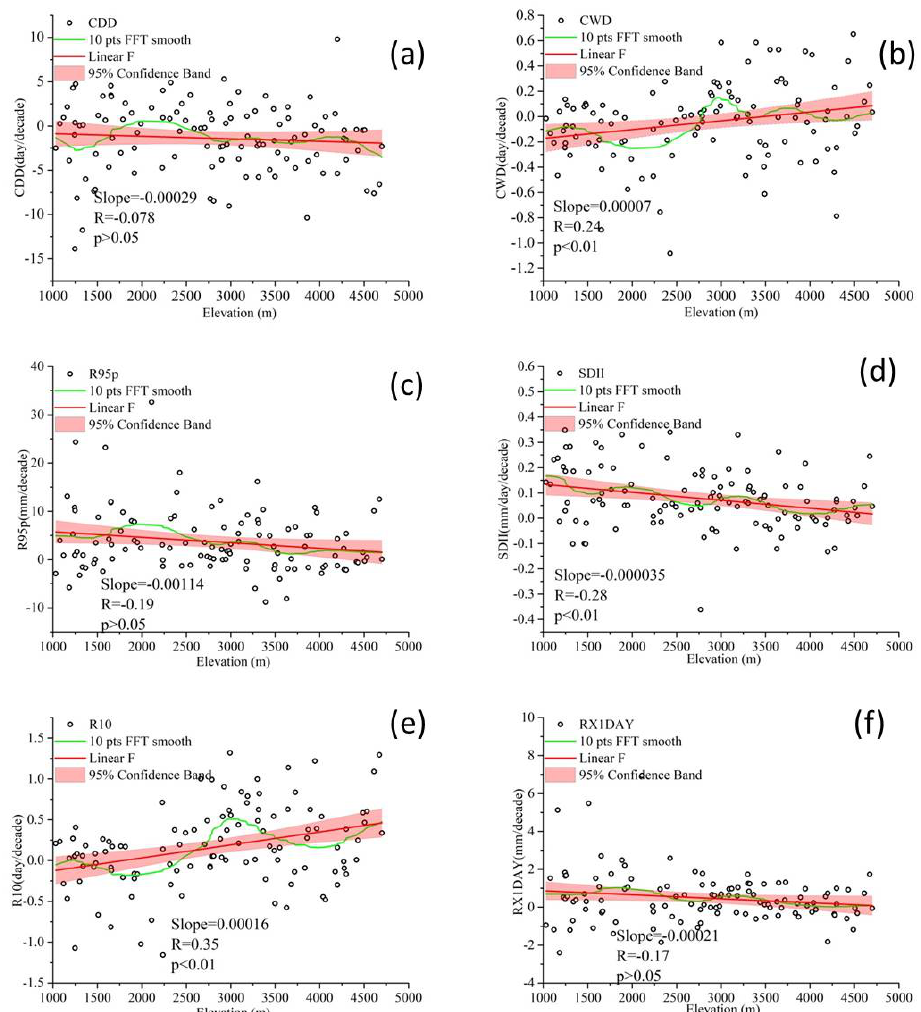
Figure 9. Scatter plots of trends (mm/decade) by elevation for extreme precipitation (( a ) CDD; ( b ) CWD; ( c ) R95p; ( d ) SDII; ( e ) R10; ( f ) RX1day) in the TP and TPS during 1971–2017. Changes in the average magnitude of each extreme precipitation index with increas- ing elevation at 500-m intervals and the number of weather stations in each gradient are shown in Figure 10. Each extreme precipitation index shows fluctuations at different ele- vations, and a simple increase or decrease with elevation was not apparent. For CDD trends, a positive correlation with elevation was observed at 1000–2000 m and a negative correlation at 2000–5000 m. However, CWD trends were more complicated; negative cor- relations with elevation were observed at 1000–2000 m, 2500–3000 m, and 3500–4000 m, and positive correlations were observed at 2000–2500 m, 3000–3500 m, and 4 000−4500 m. Positive correlations with elevation for R95p trends were observed at 1000–2000 m, 2500– 3000 m, and 4000–4500 m, and negative correlations were observed at 2000–2500 m, and 3000–4000 m. For SDII trends, negative correlations with elevation were observed at 1000– 2500 m and 3000–4000 m, and positive correlations were observed at 2500–3000 m and 4000–4500 m. For R10, negative correlations with elevation were observed at 1000–1500 m and 3000–4000 m, and positive correlations were observed at 1500–3000 m and 4000–4500 m. For RX1day, positive correlations with elevation were observed at 1000–1500 m, 2500–